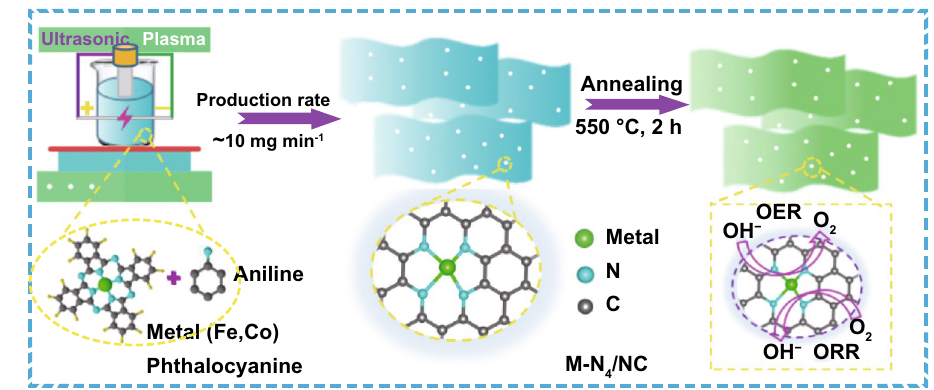
Fig. 1 Schematic of ultrasonic plasma engineering fabrication of M-N 4 /NC (M = Fe,